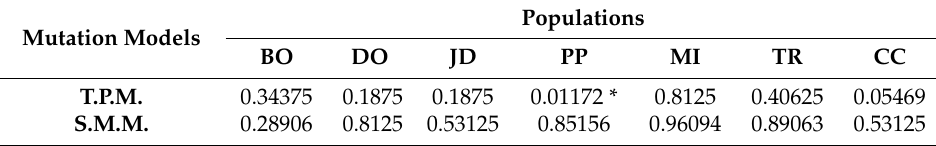
Table 5. Wilcoxon test for bottlenecks in the populations of the Campomanesia adamantium . Populations Mutation Models BO DO JD PP